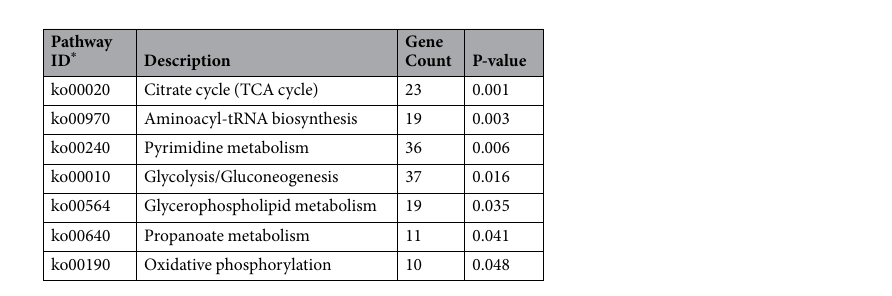
Table 3. KEGG pathway enrichment of circRNA-host genes in soybean. * Pathway with the threshold of P-value < 0.05 was